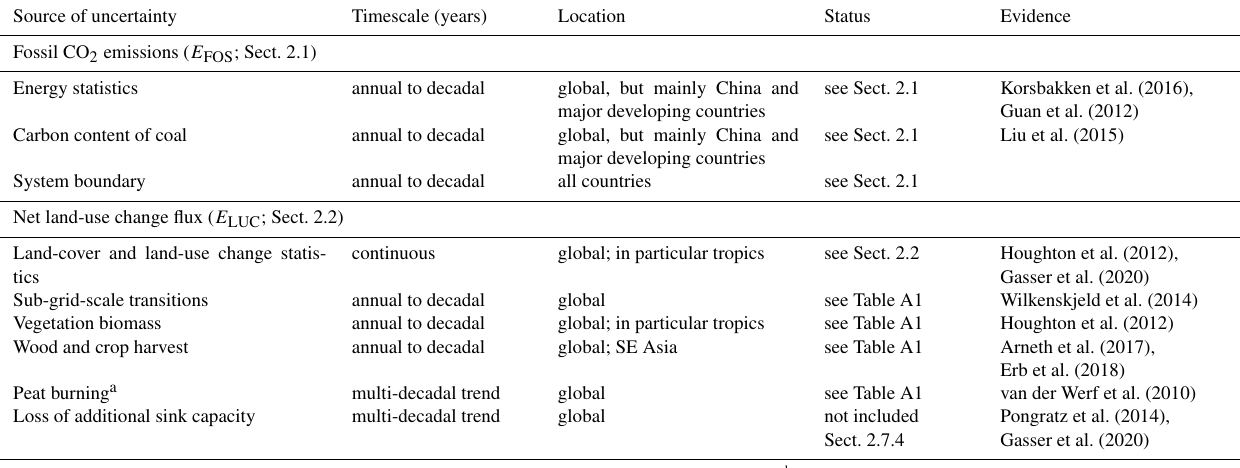
Table 9. Major known sources of uncertainties in each component of the Global Carbon Budget, defined as input data or processes that have a demonstrated effect of at least ± 0.3GtCyr − 1